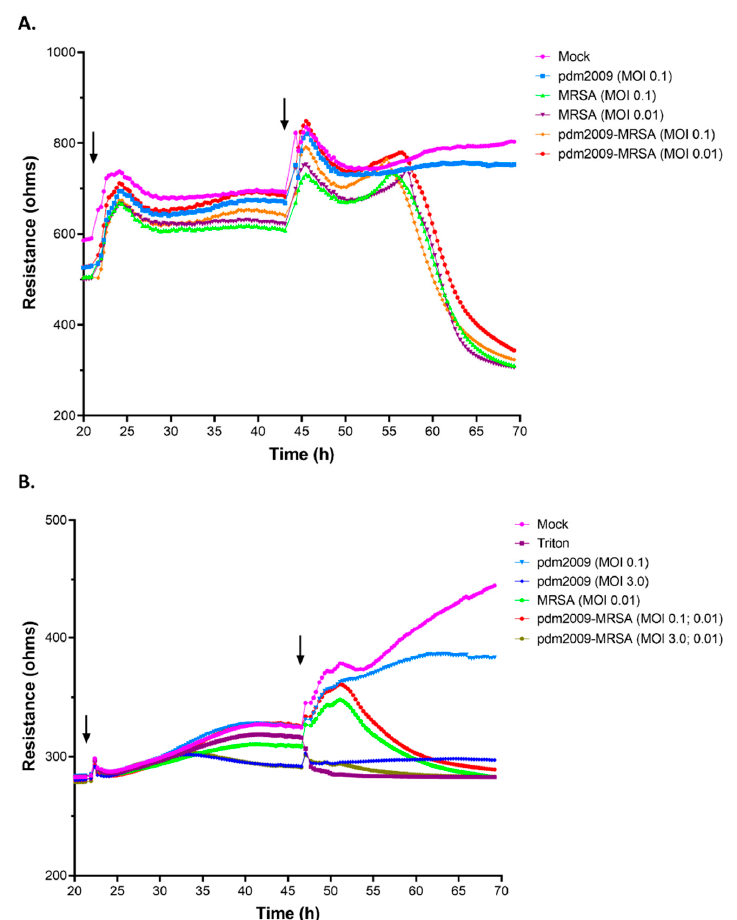
Figure 5. pdm2009-MRSA infection decreases barrier function in alveolar epithelial cells. Median resistance values have been plotted for all data points obtained during the experiment. Error bars have been removed to allow for clear visualization of all datasets, but were consistent across all biological replicates. A549 cells were plated 24 h prior to initial infection with pdm2009. Cells were infected or mock-infected with pdm2009, and MRSA was added to cells 24 h later. MRSA-alone, pdm2009-alone, 1% triton, and mock-infected time-matched conditions were also analyzed at the indicated time points. MOI values in parentheses signify the MRSA MOI utilized for infection. ( A ) Resistance data following infection with pdm2009 (MOI 0.1) and/or MRSA (MOI 0.1 or 0.01). ( B ) Resistance data following analysis with high MOI pdm2009 (MOI 0.1 or 3) and/or low MOI MRSA (MOI 0.01). Resistance data represent the median of at least three biological replicates with at least six technical replicates per sample per biological replicate. Arrows designate the addition of pdm2009 (first arrow) and MRSA or triton (second arrow) to the